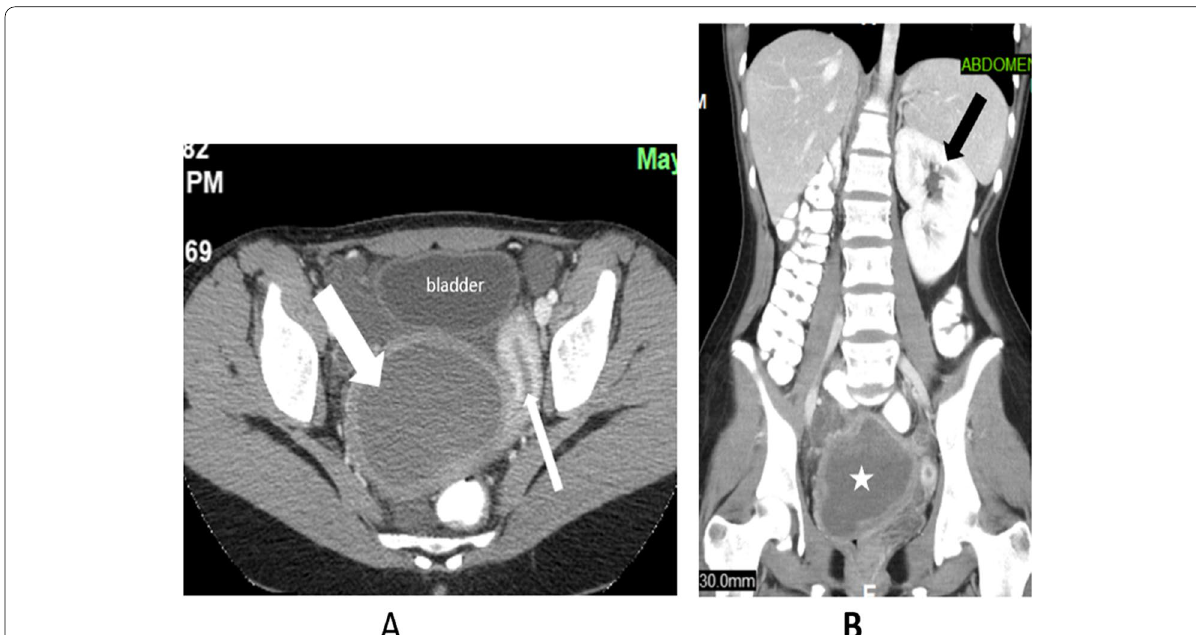
Fig. 2 CT scan showed A distended obstructed right hemi-vagina (hematocolpos wide arrow), right hemi-uterus (thin arrow), and B absent right kidney and compensatory hypertrophy of left kidney (black arrow) and hematocolpos